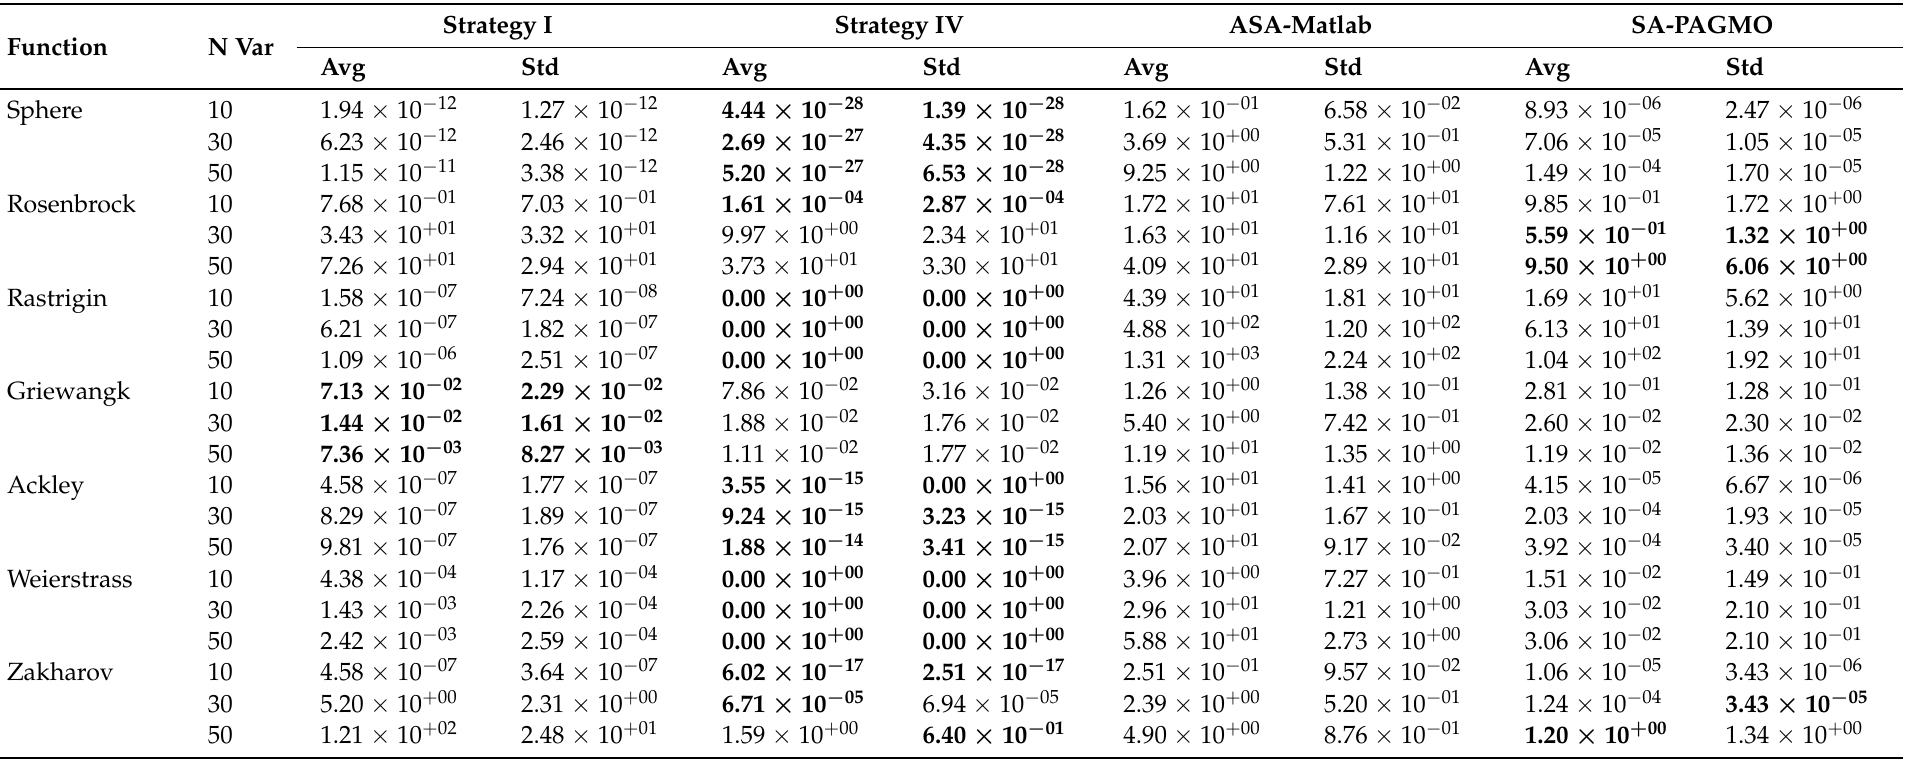
Table 4. Results of the benchmark function for 100 repetitions. N var is the number of variables, avg is the average of the costs, and std is the standard deviation. Strategy I is the reset of the crystallization factor, strategy IV is the hybrid decrease, reset of the crystallization in the beginning, and decrease by three unities at the end. According to Ingber, Matlab uses ASA [17,26]. PAGMO uses the SA approach proposed by Corana et al. [15,27]. The best results are emphasized in bold.